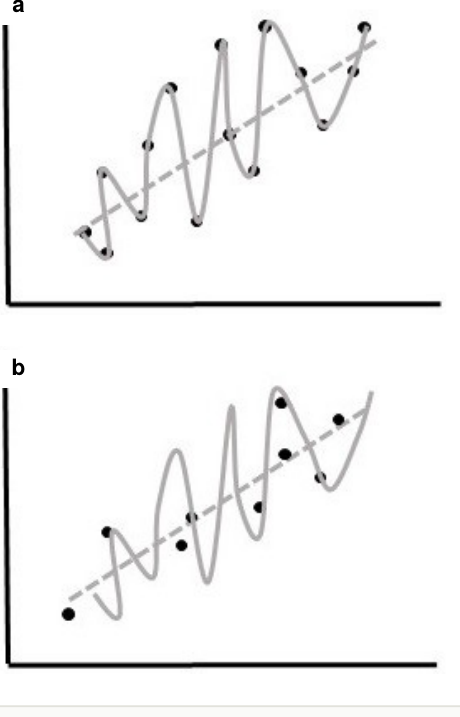
Figure 2. Comparison of performance of two algorithms (grey lines) on hypothetical training (A) and test (B) data (black